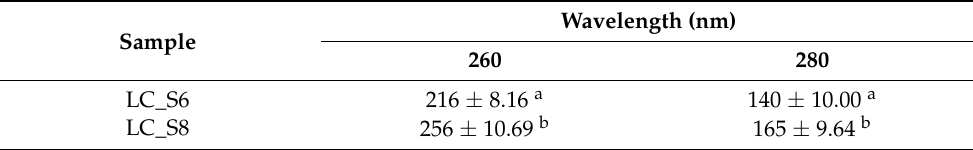
Table 4. Absorbance increase (%) at 260 and 280 nm of the supernatant after the sonication treatment of Lacticaseibacillus casei ATCC 393 cells. LC_S6: treatment at 57 W with 50% DC for 6 min; LC_S8: treatment at 57 W with 50% DC for 8